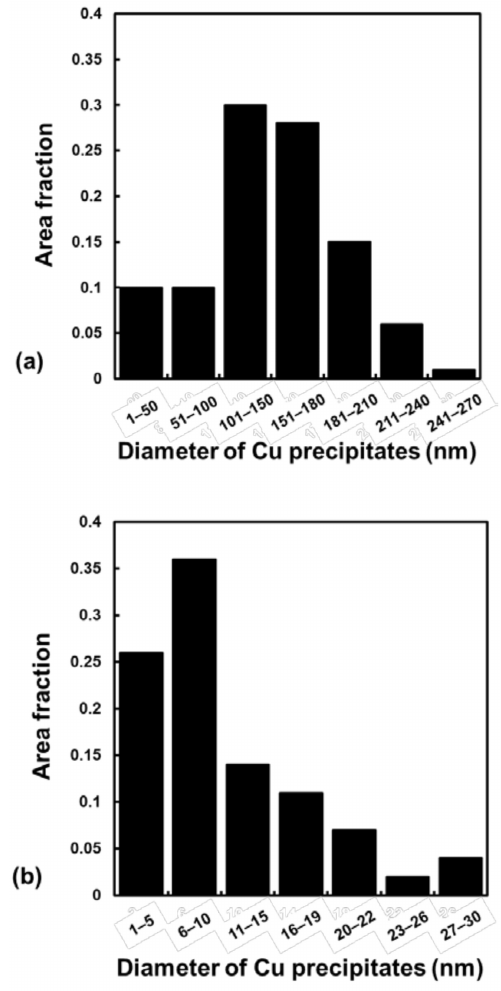
Figure 17. Size distribution of Cu precipitates of P21 steel after laser-assisted heat treatment at 1473 K: ( a ) softening zone and ( b ) base metal